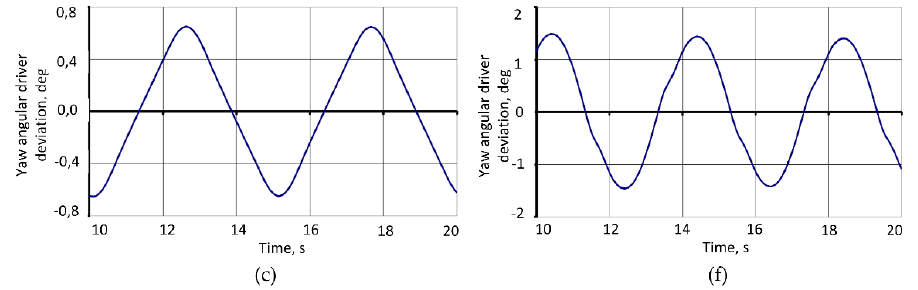
Figure 11. Example of simulation for anticipative driver siting before front axle of vehicle—( a ) hydraulic actuator displacement, ( b ) lateral displacement of front—1 and rear—2 axle, ( c ) yaw angular driver deviation, ( d ) hydraulic actuator displacement, ( e ) lateral displacement of front—1 and rear—2 axle, and ( f ) yaw angular driver deviation.